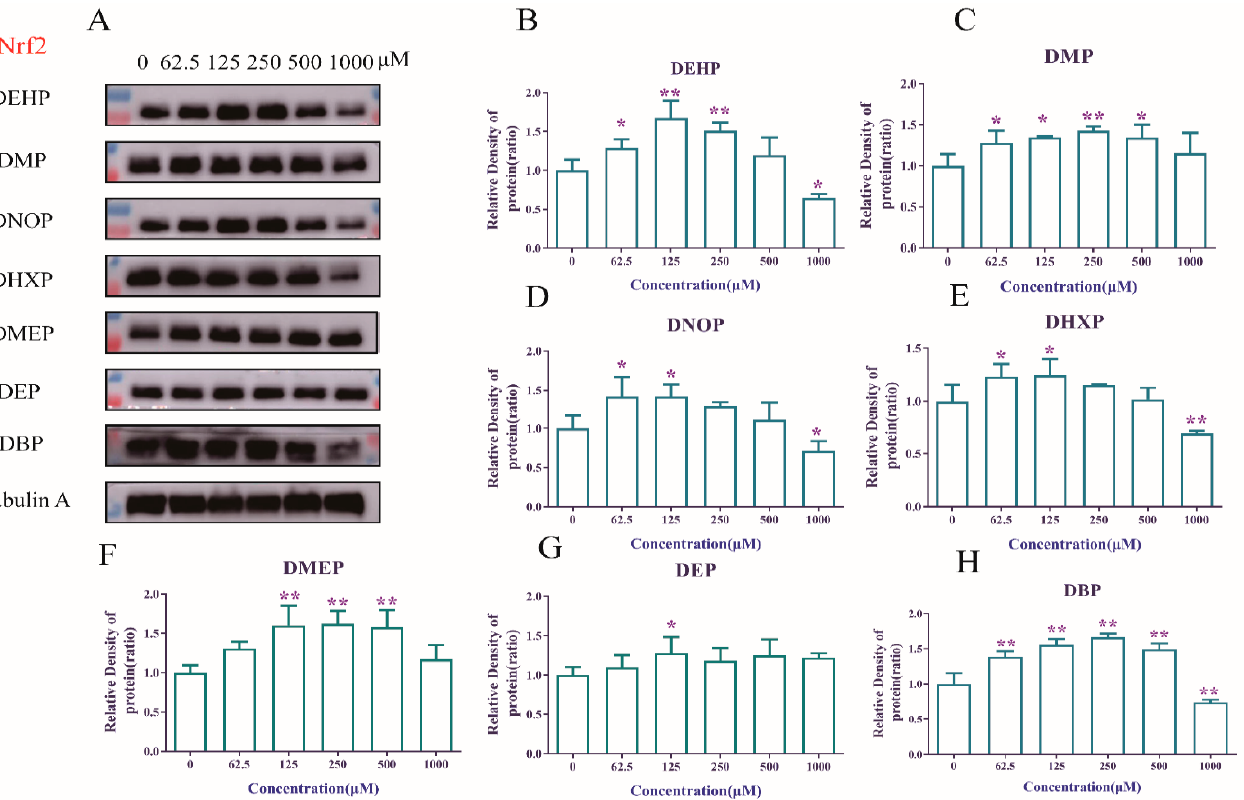
Figure 2. The influence of PAEs on cell Nrf2 content. Cells were treated with 62.5, 125, 250, 500 and 1000 µ M PAEs for 48 h. ( A ): Western blot strips of PAEs; ( B ): DEHP, ( C ): DMP; ( D ): DNOP; ( E ): DHXP; ( F ): DMEP; ( G ): DEP; ( H ): DBP. Data are expressed as mean ± SD, n = 3. * p < 0.05, ** p < 0.01 versus the control group.